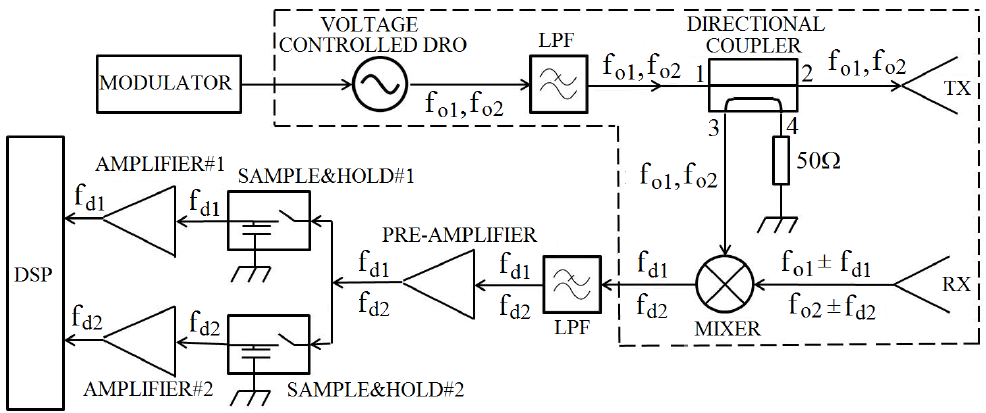
Figure 1. Block diagram of the whole MURENA sensor (the microwave subsystem is included in a dashed box).